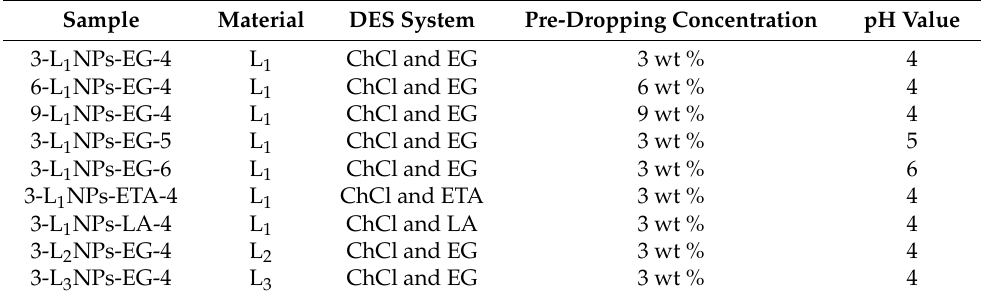
Figure 1. Schematic representation of the preparation procedure of lignin nanoparticles (LNPs). DES: deep eutectic solvent. Table 1. LNPs obtained from different conditions.